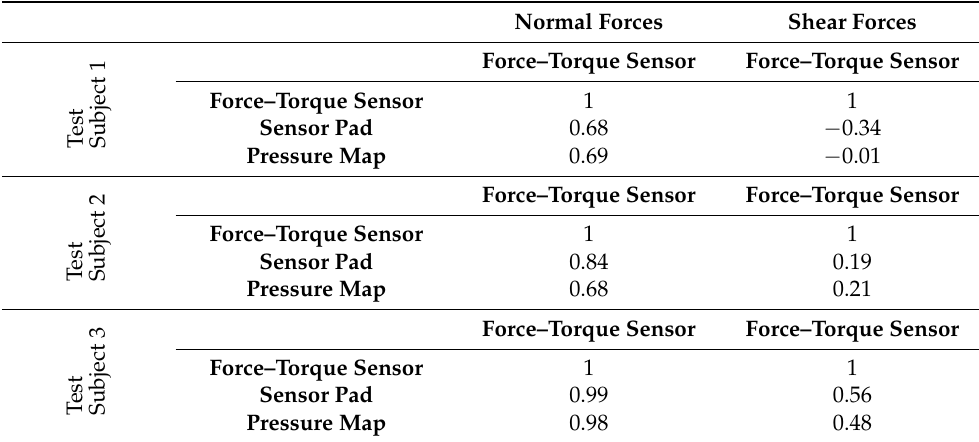
Table 1. Correlation matrix with respective correlation coefficients for the detection of normal and shear forces, exemplarily applied on three different test subjects. Normal Forces Shear Forces Force–Torque Sensor Force–Torque Sensor Force–Torque Sensor 1 1 b j s t 0.68 − u T e S